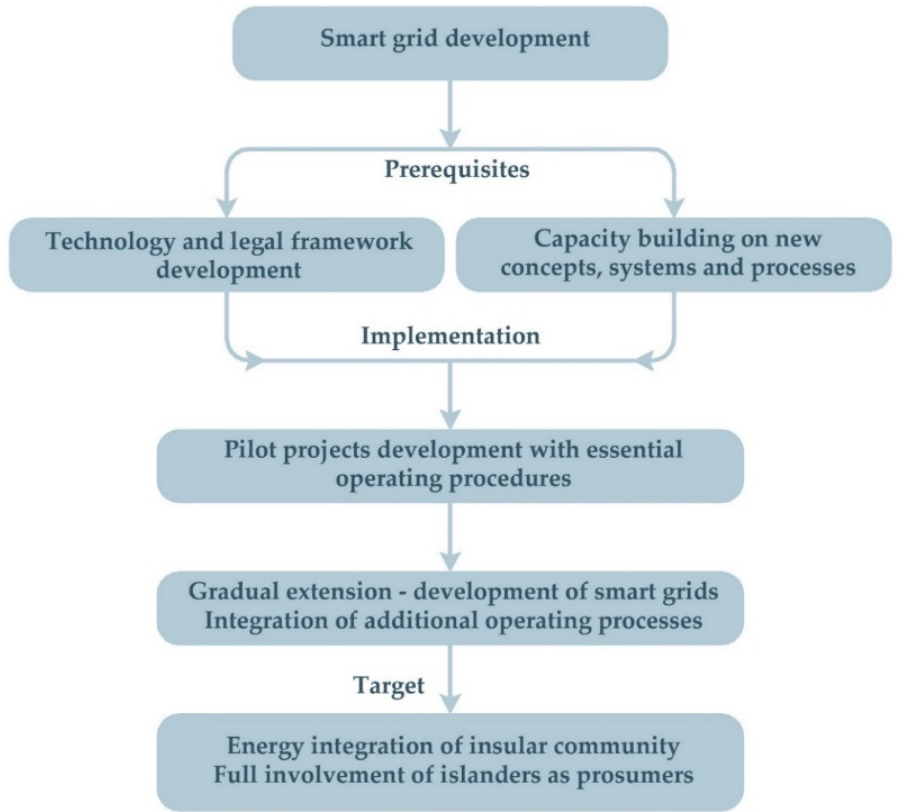
Figure 31. Roadmap and target for the introduction of smart grid in Crete.